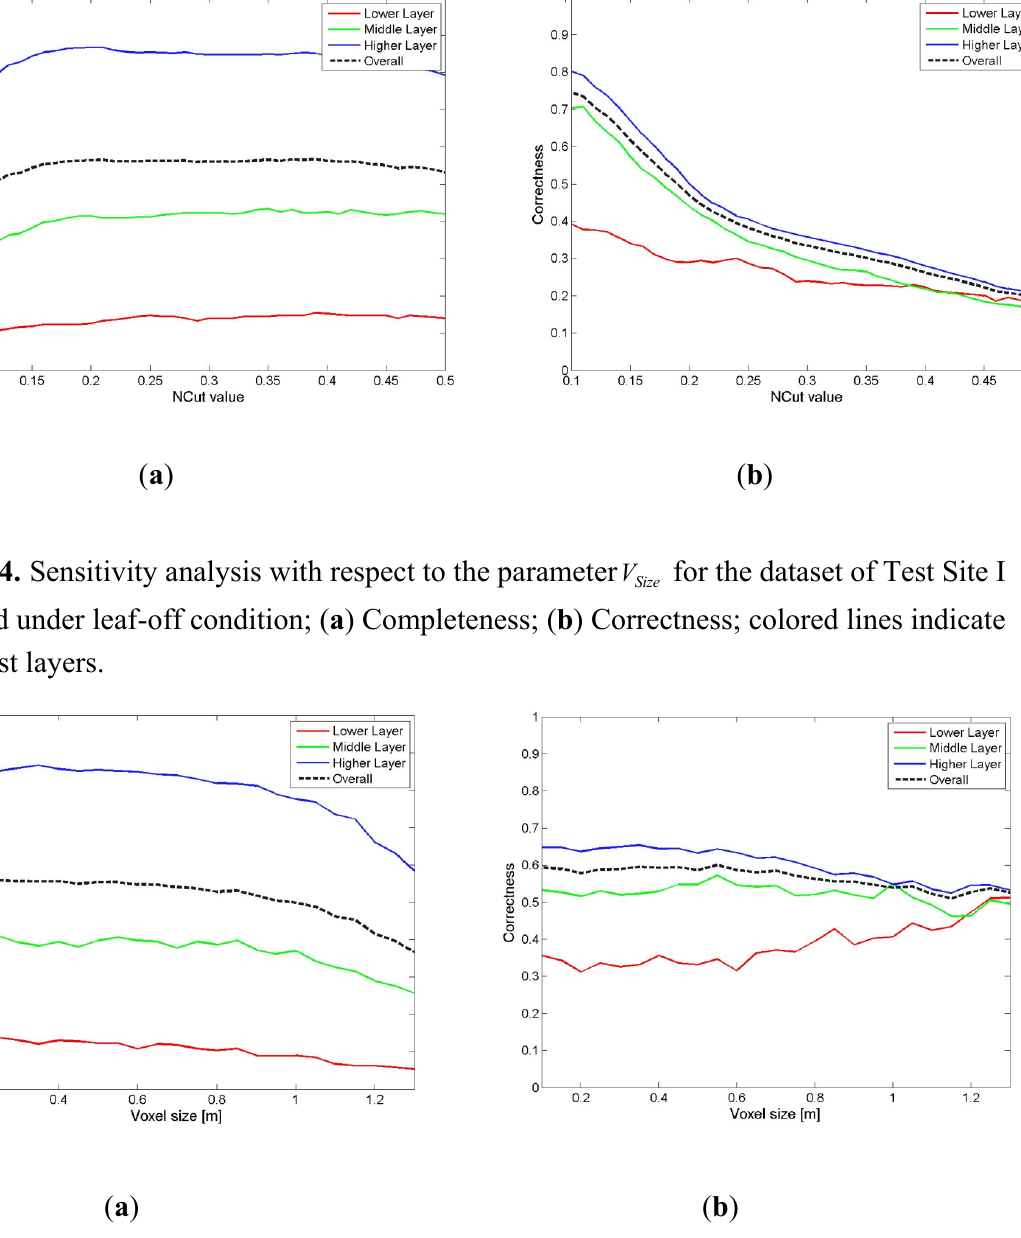
Figure 3. Sensitivity analysis with respect to the parameter NCut Site I acquired under leaf-off condition; ( a ) Completeness; ( b ) Correctness; colored lines indicate the forest layers.